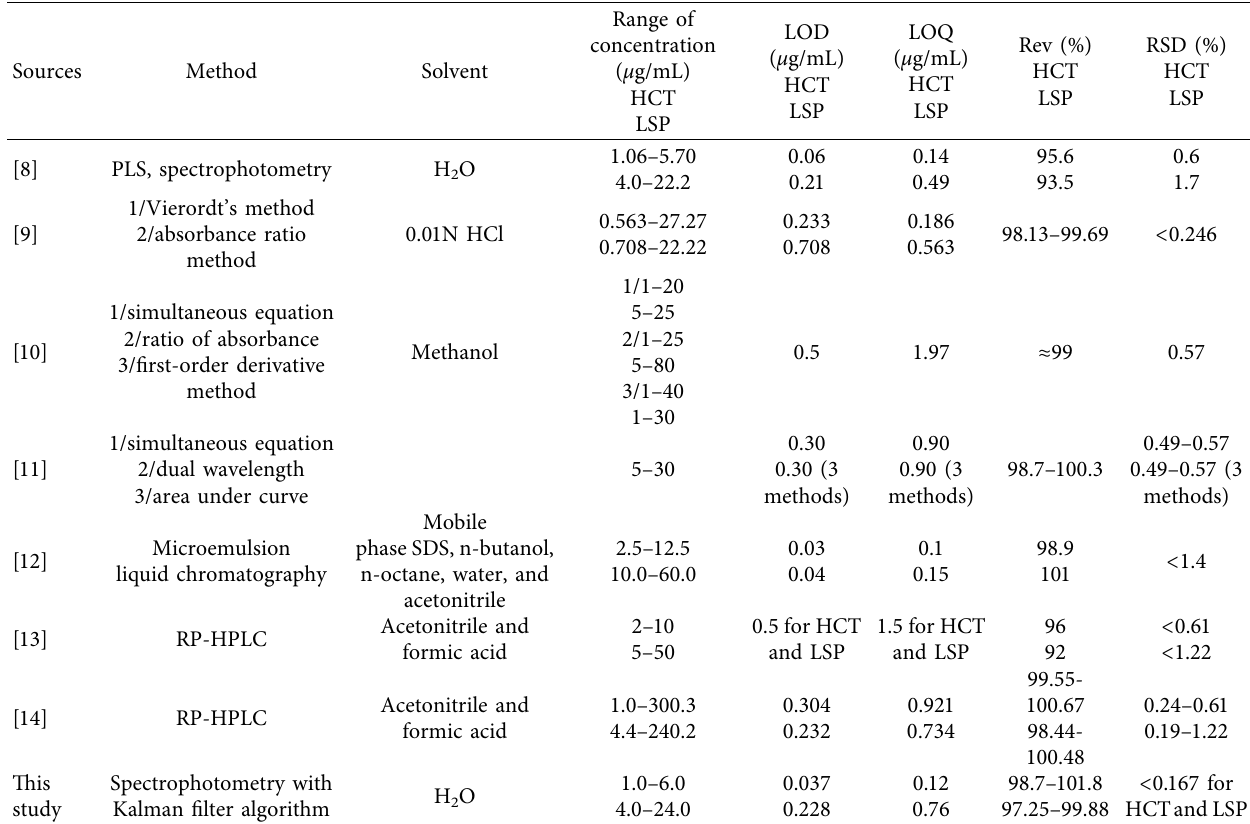
Table 4: The validation results of other methods in comparison with this Kalman-Excel method for the determination of HCTand LSP in